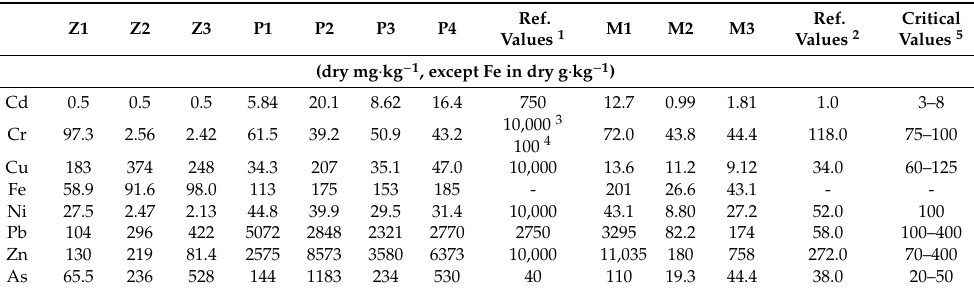
Table 3. Pseudo-total metal content in